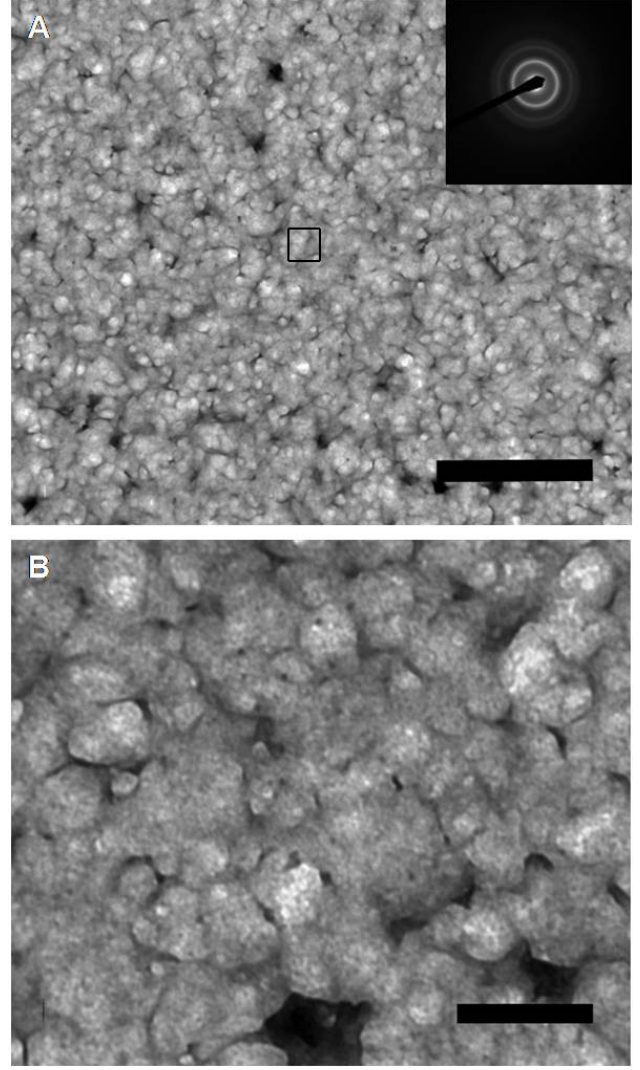
Figure 3. Transmission electron microscopy images of pDNA-HCcp3 The pDNA is the pUC18 plasmid, and the bp to dimer ratio is 20 to 1. ( B ) The magnified micrograph of selected area in ( A ). The inset in ( A ) is the selected area of the electron diffraction patterns showed several rings, indicating that the liquid crystalline particles of pDNA-HCcp3 complexes were not well crystallized. Scale bar in panel ( A) : 1 µm; Scale bar in panel ( B) 200